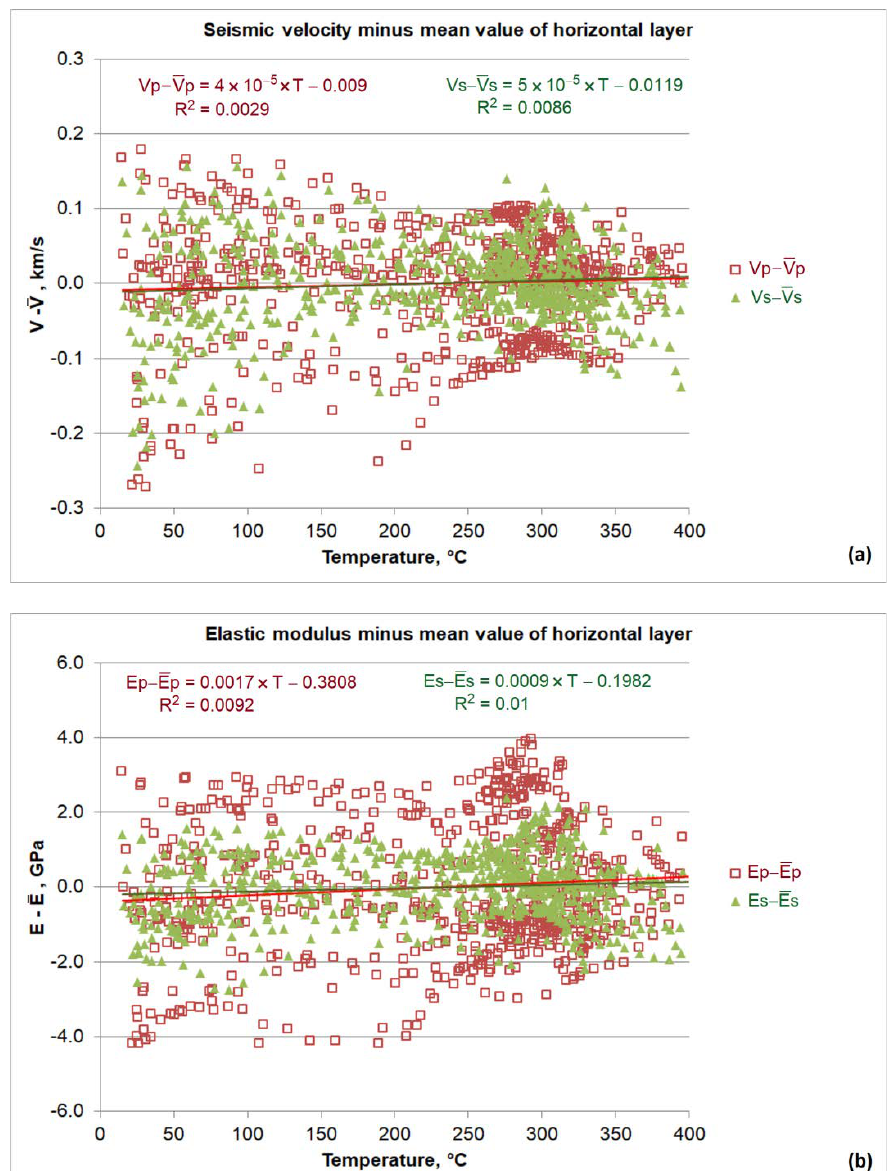
Figure 3. Difference between seismic properties (( a ) velocities and ( b ) elastic moduli) and their average values at the same elevation (or depth) above sea level, as derived from the passive seismic survey, versus temperature in Los Humeros.